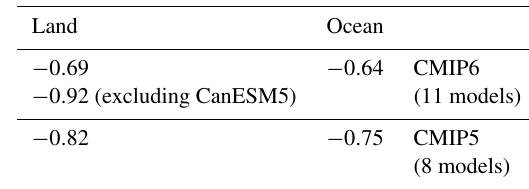
Table 3. Correlation between carbon–concentration ( β X ) and carbon–climate ( γ X ) feedback parameters over land and ocean across comprehensive ESMs from the CMIP5 intercomparison in the A13 study and CMIP6 intercomparison in this study. For the land correlation it is also shown when CanESM5 is excluded from CMIP6